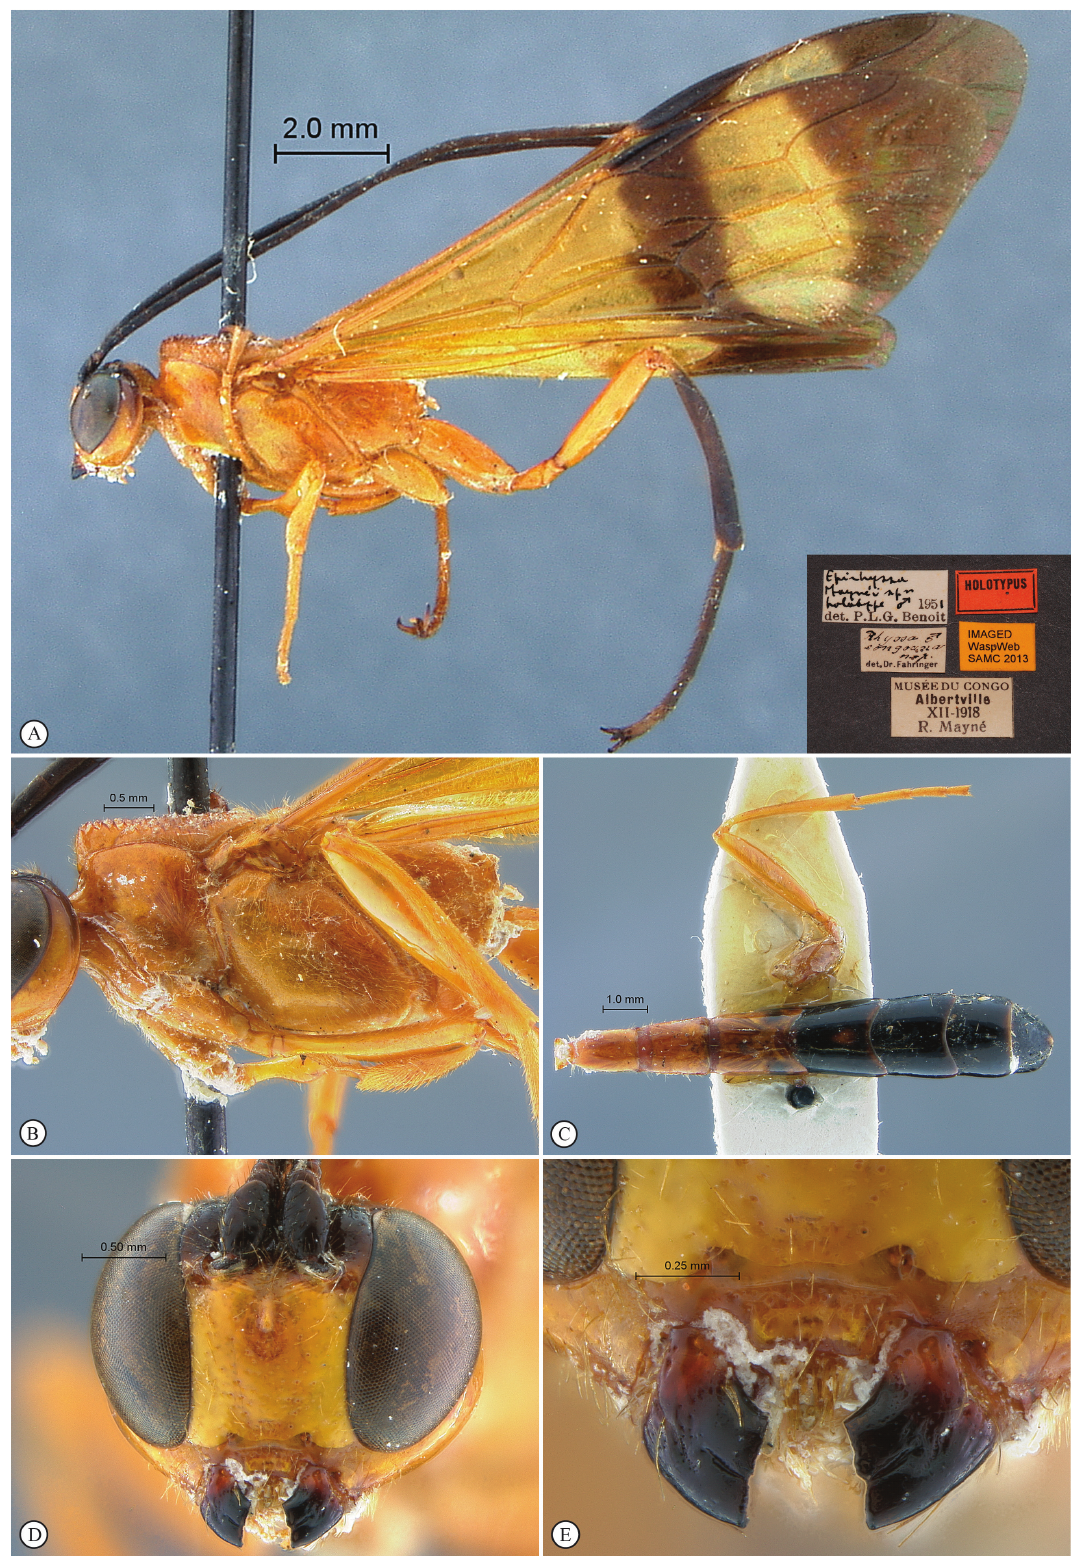
Fig. 5. Epirhyssa maynei Benoit, 1952, holotype, ♀. A . Habitus, lateral view (inset: data labels). B . Mesosoma, lateral view. C . Metasoma, dorsal view. D . Head, anterior view. E . Mandibles, anterior